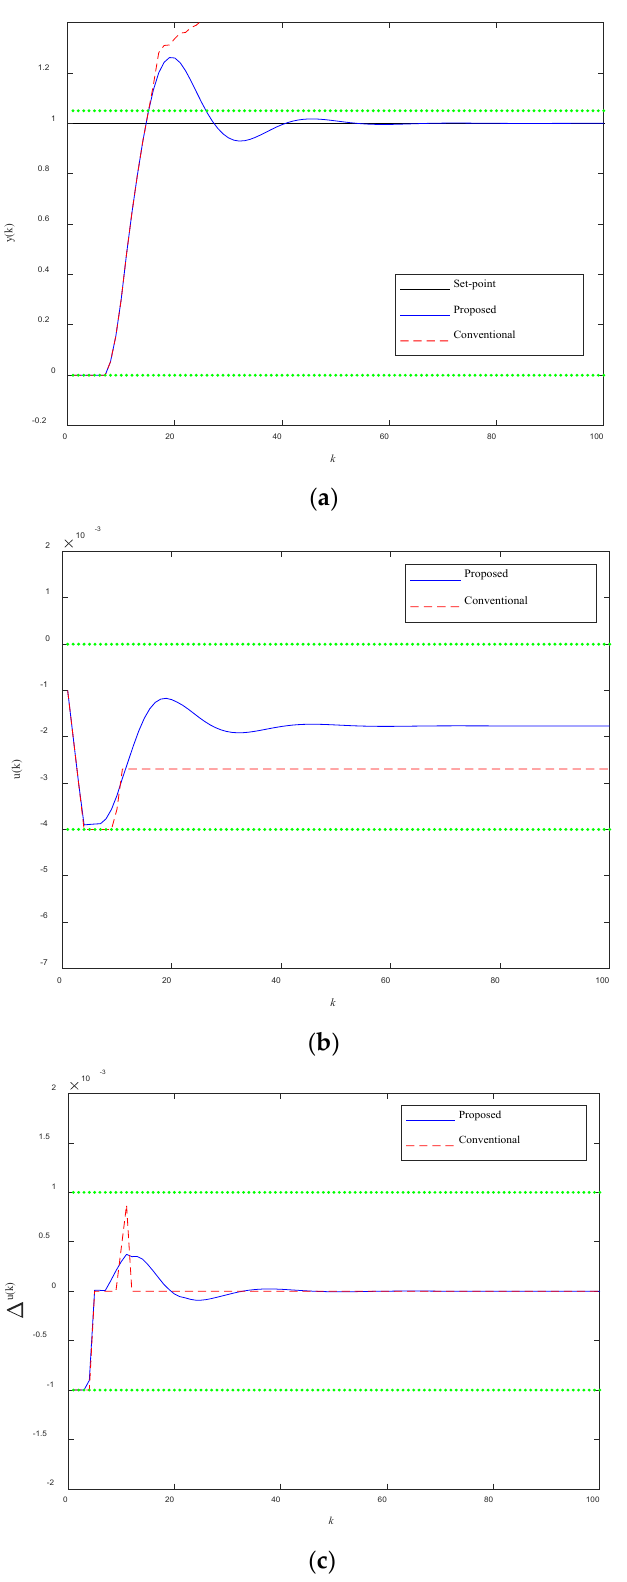
Figure 6. ( a ) Output responses under case 3 and rigorous constraints; ( b ) input responses under case 3 and rigorous constraints; ( c ) input increment responses under case 3 and rigorous constraints.